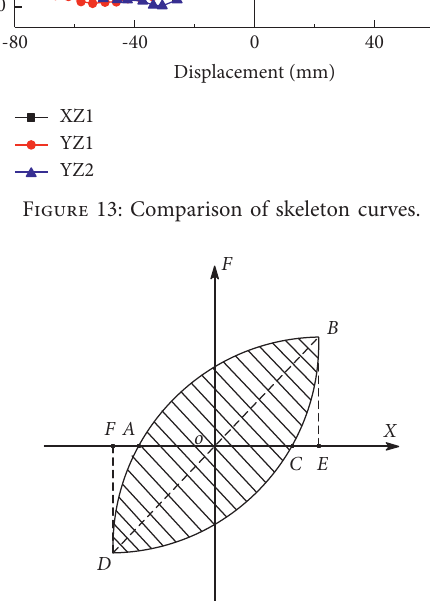
Figure 14: Calculation of energy dissipation from force-dis- placement hysteresis curve.